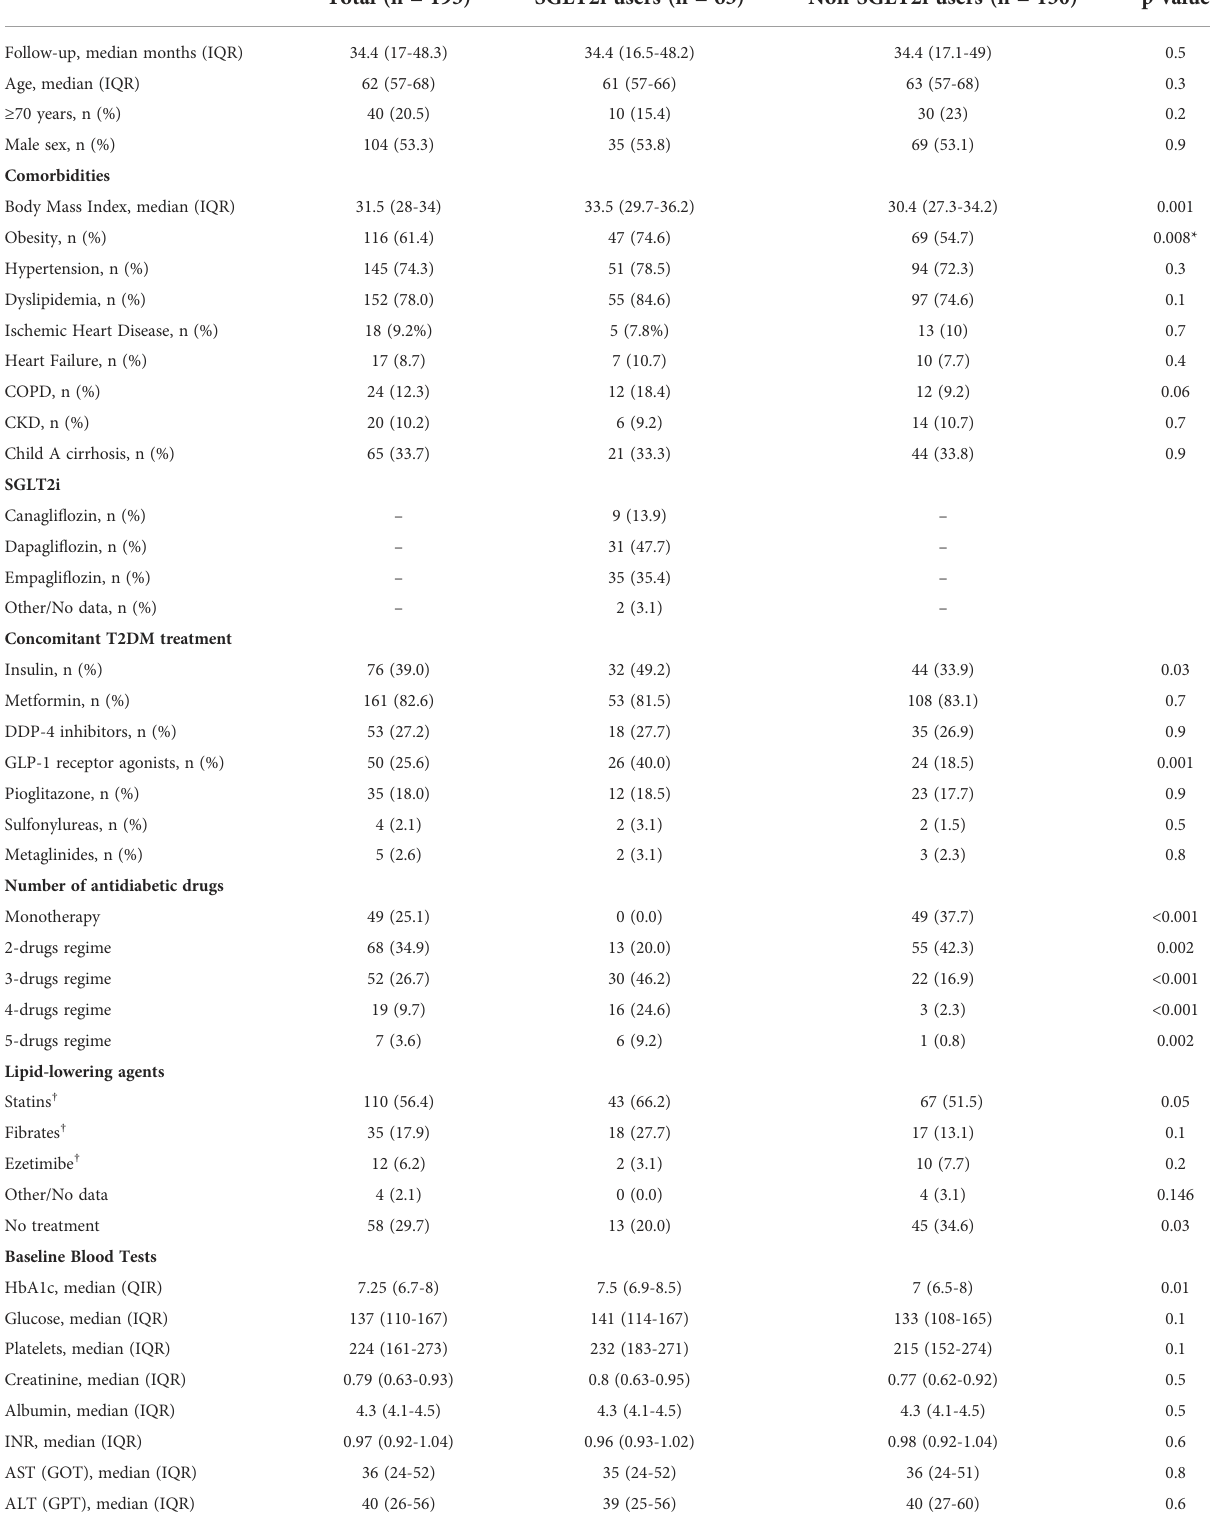
TABLE 1 Demographics and clinical characteristics of cases (SGLT2i users) and controls (non-SGLT2i users) in a cohort of patients with NAFLD and type 2